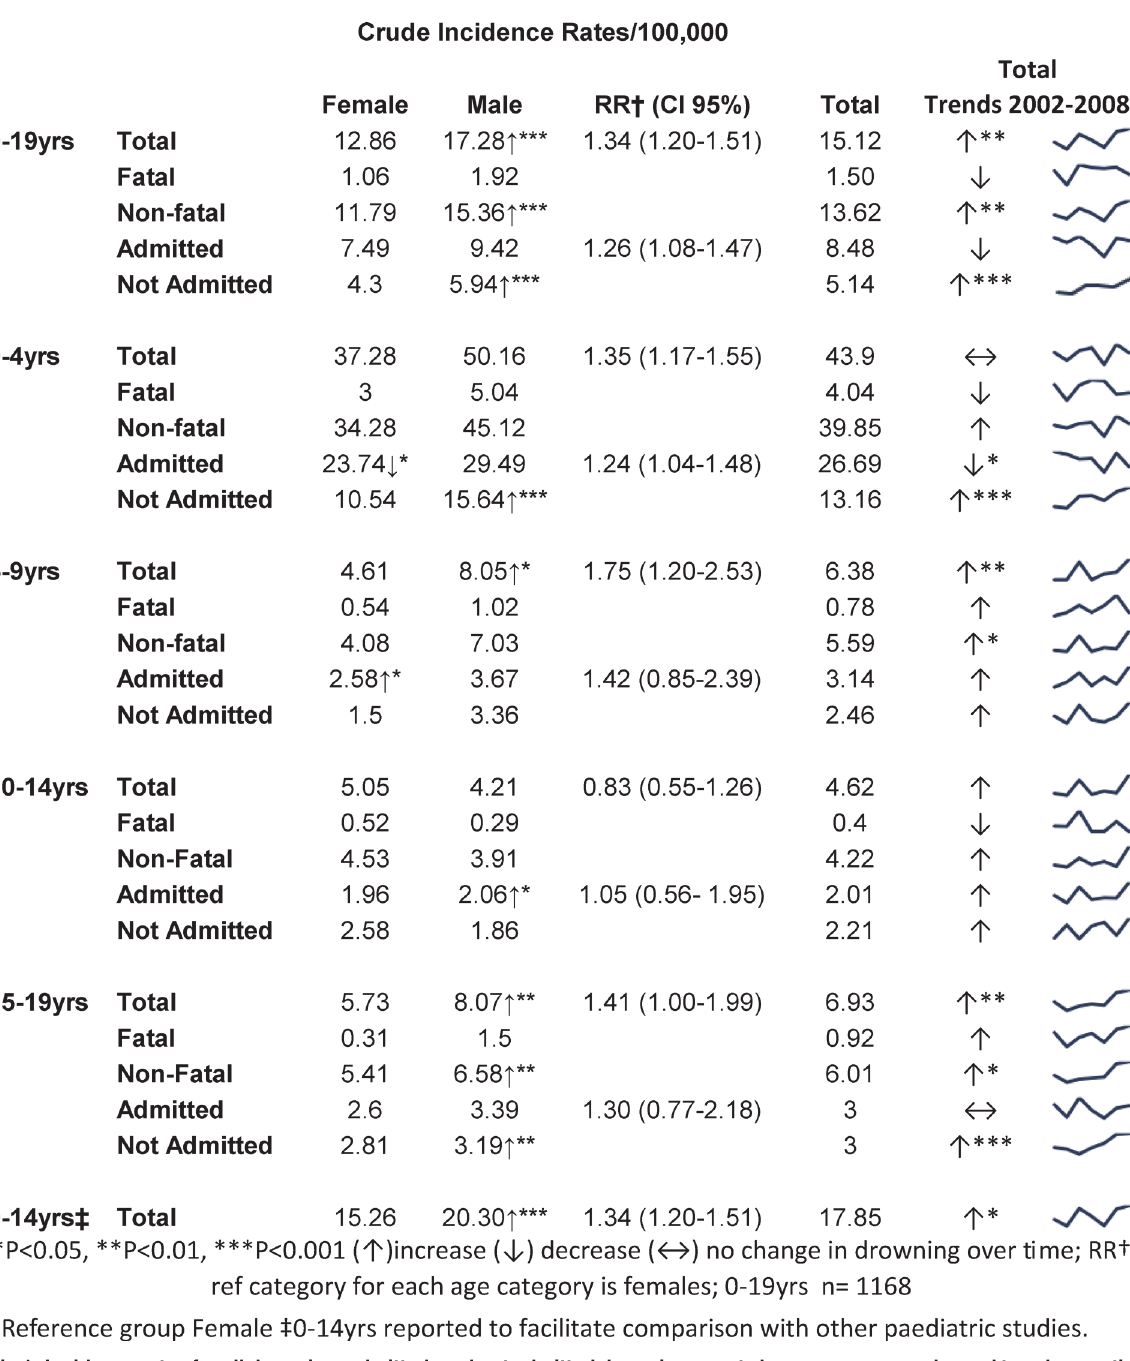
Fig 1. Incidence rates for all drowning, admitted, and not admitted drowning events by age group, gender and trends over time for 2002 –